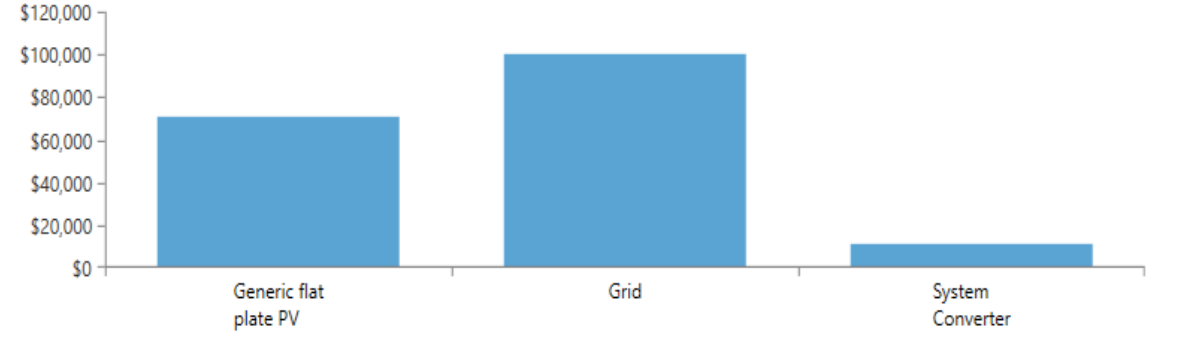
Figure 13. Summary on investment costs.